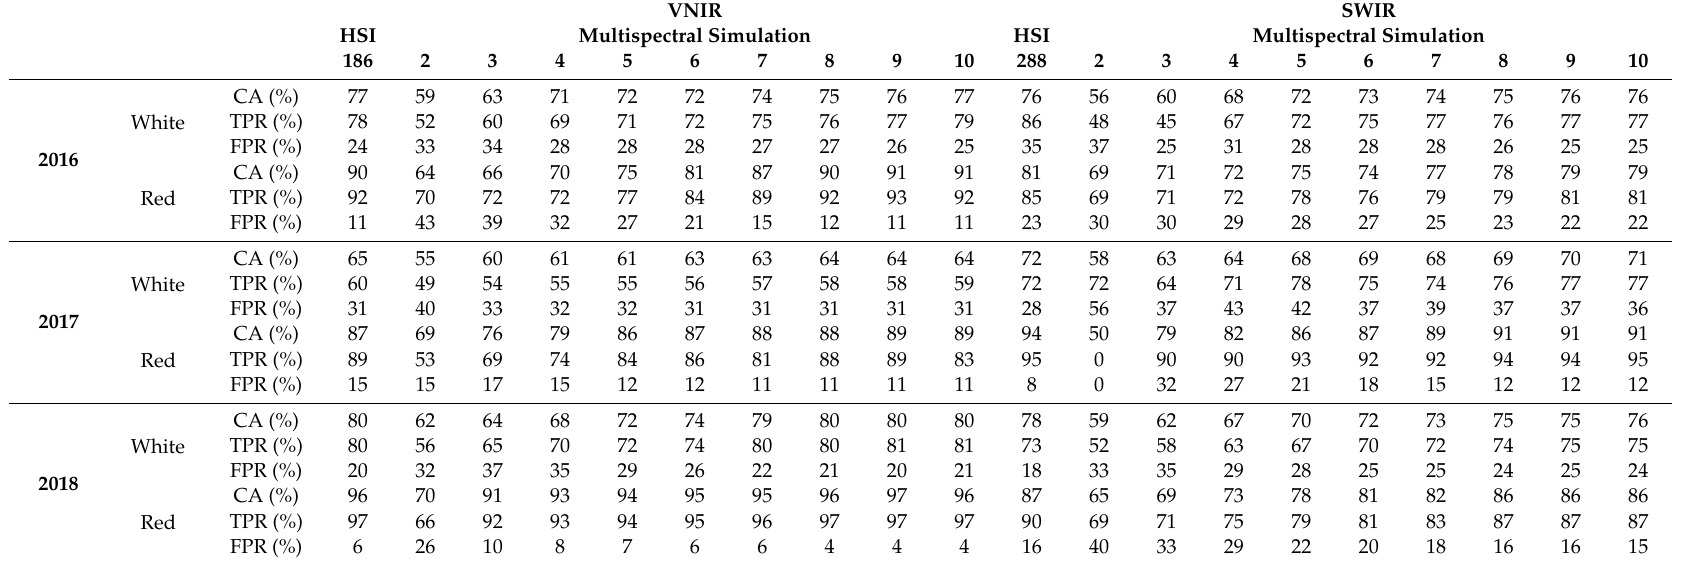
Table 13. Results of the multispectral simulation for GLRaV-1 symptom